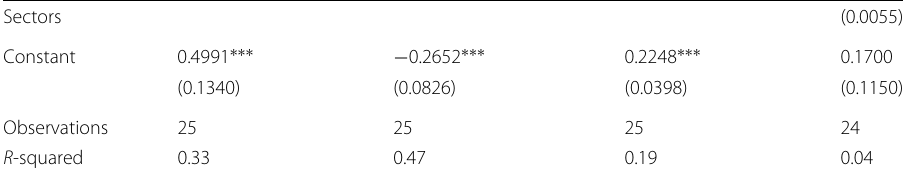
Table 8 Bivariate relationships between the government monopolistic power and the wage gap ( Continued ) Sectors (0.0055) Constant 0.4991 ∗∗∗ − 0.2652 ∗∗∗ 0.2248 ∗∗∗ 0.1700 (0.1340) (0.0826) (0.0398) (0.1150) Observations 25 25 25 24 R -squared 0.33 0.47 0.19 0.04